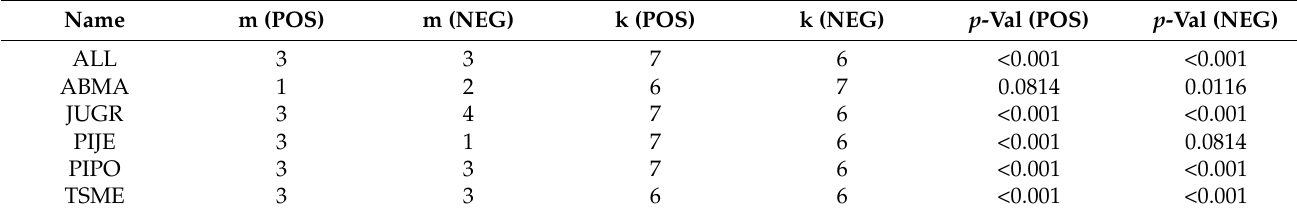
Figure 4. Significance of tracking of whiplash events in P12 by reconstructions as a function of variance explained by reconstruction model. Significance estimated by hypergeometric analysis for positive (left) and negative (right) events. The y-axis is the p -value (log scale) for rejection of the null hypothesis that a number of matches or greater could occur by chance. Colors code species-specific and full-network (All) models. Table 3. Significance of tracking of positive (POS) and negative (NEG) whiplash events in P12 by species-specific and full-network reconstructions as estimated by the hypergeometric test. Sample size (N s = 69) and maximum possible event matches (M = 6) are the same for all reconstructions. The last two columns list the probability, by chance alone, of m-or-more successes (events identified) given k draws from the sample.